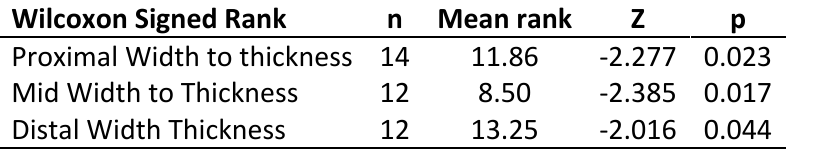
Table 13. Wilcoxon Signed Rank tests for width to thickness against total number of projections.